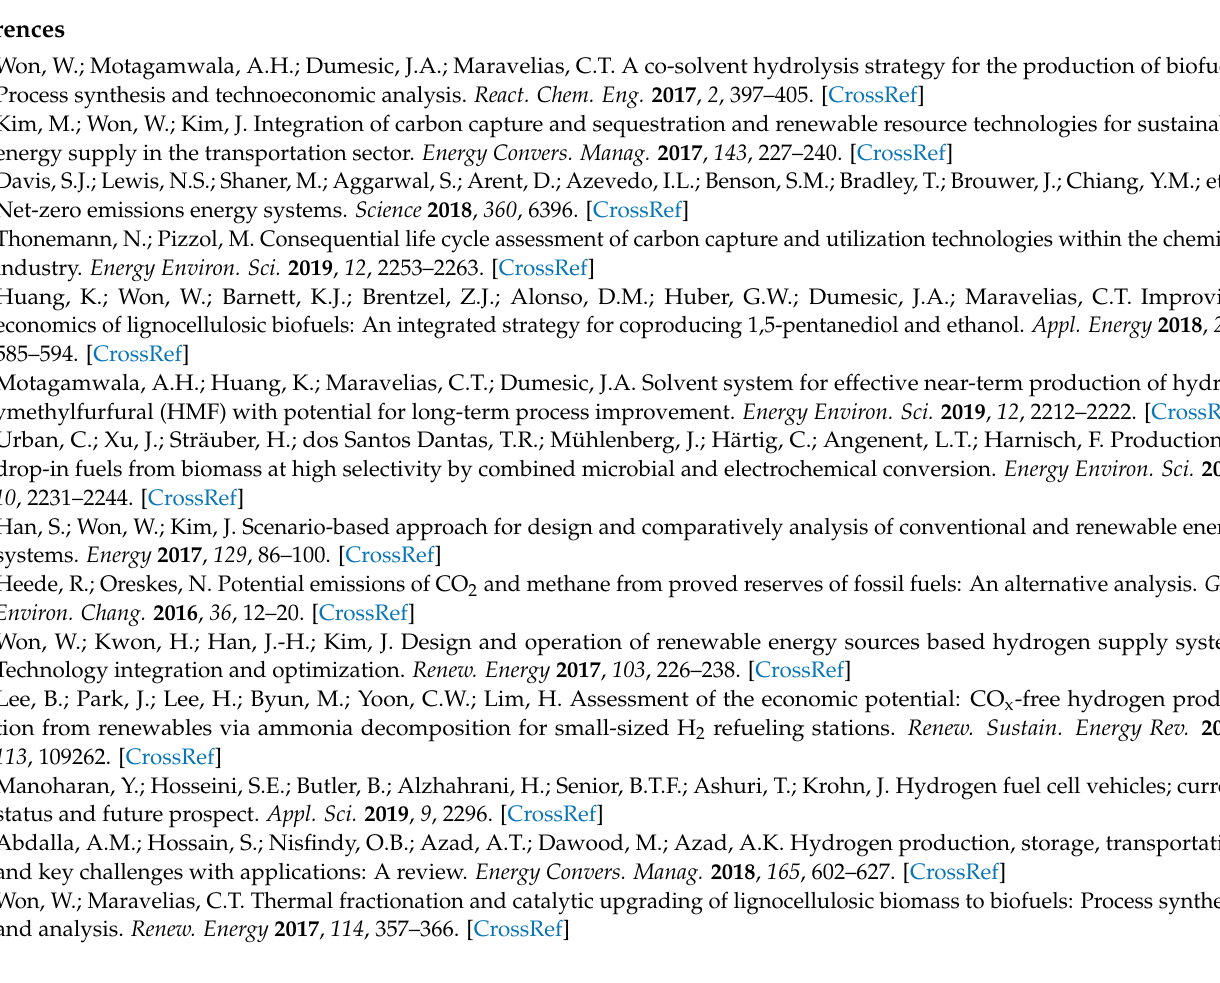
reforming process in scenario 4, Table S1: Process stream information for scenario 1, Table S2: Process stream information for scenario 2, Table S3: Process stream information for scenario 3, Table S4: Process stream information for scenario 4, Table S5: Equipment cost in scenario 1, Table S6: Equipment cost in scenario 2, Table S7: Equipment cost in scenario 3, Table S8: Equipment cost in scenario 4, Table S9: Discounted cash flow for scenario 1, Table S10: Discounted cash flow for scenario 2, Table S11: Discounted cash flow for scenario 3, Table S12: Discounted cash flow for scenario 4, Table S13: Discounted cash flow for scenario 5, Table S14: Discounted cash flow for scenario